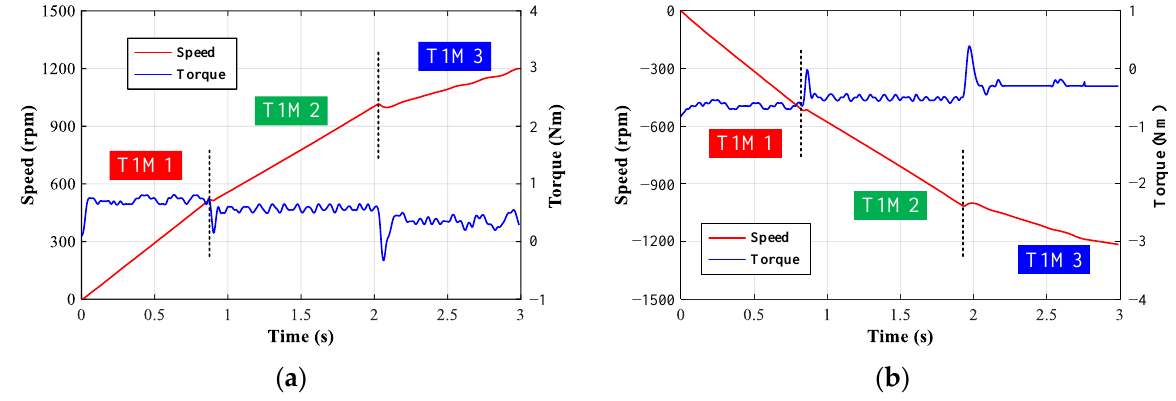
Figure 14. Torque and speed curves during the acceleration process of the DS-PMM prototype using the WS control strategy. ( a ) Positive speed. ( b ) Negative speed.